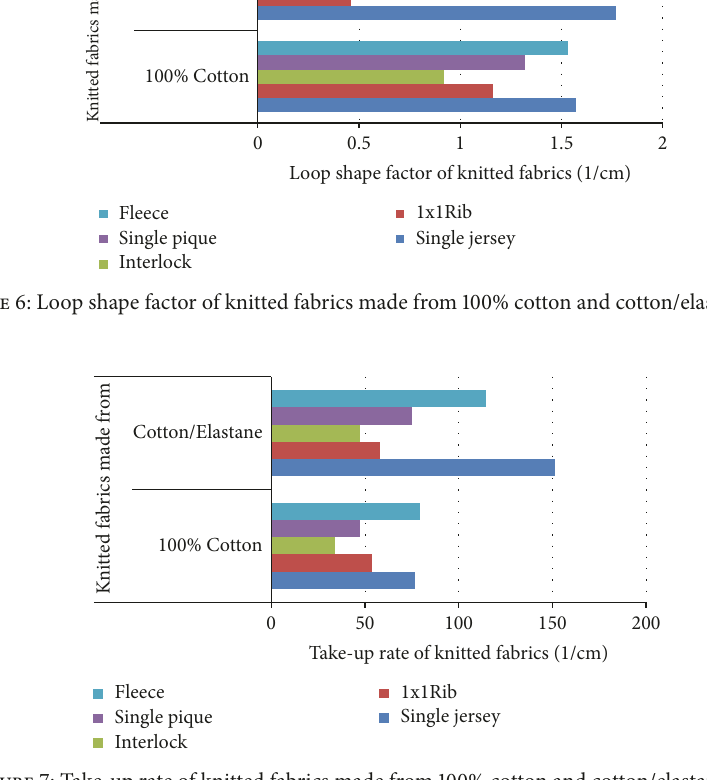
Figure 7: Take-up rate of knitted fabrics made from 100% cotton and cotton/elastane